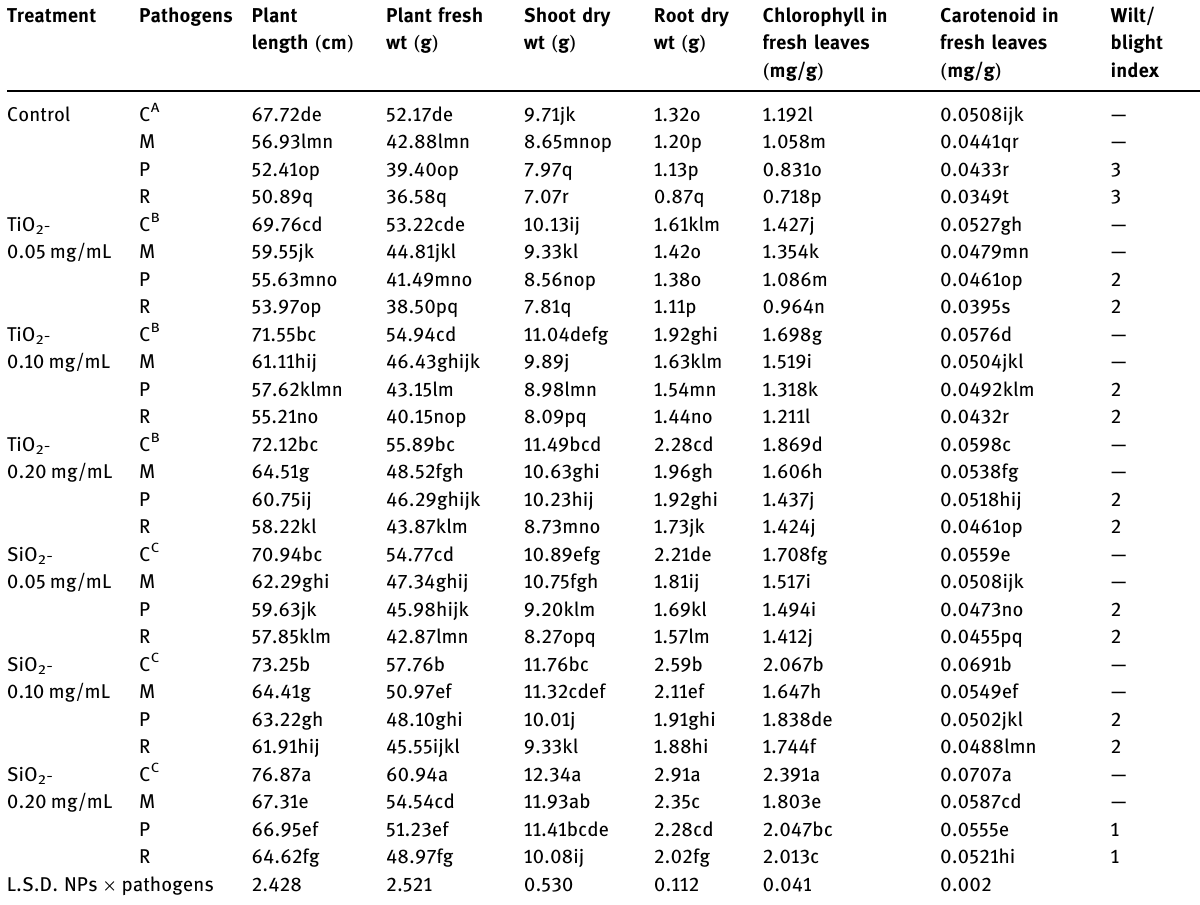
Table 3: E ff ect of SiO 2 - NPs and TiO 2 - NPs on the plant growth and photosynthetic pigments of eggplants inoculated with test pathogens, i.e. , M. incognita , P. vexans , and R. solanacearum and uninoculated